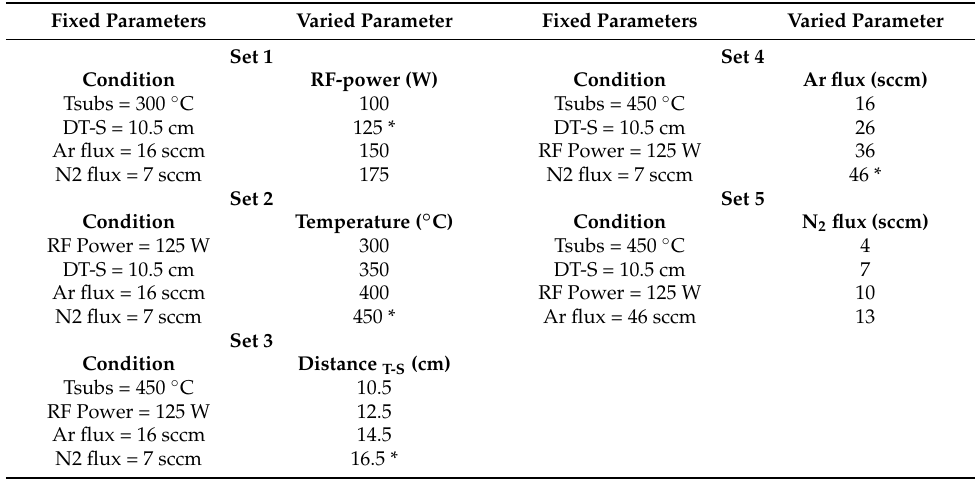
Table 1. Deposition parameters of Ti/Ti 2 N films divided in five parameters